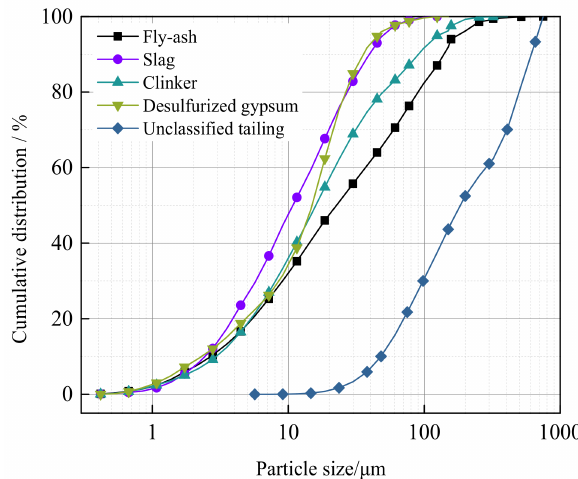
Figure 11. Particle size distribution curve of cementitious material for each component and unclassi- fied